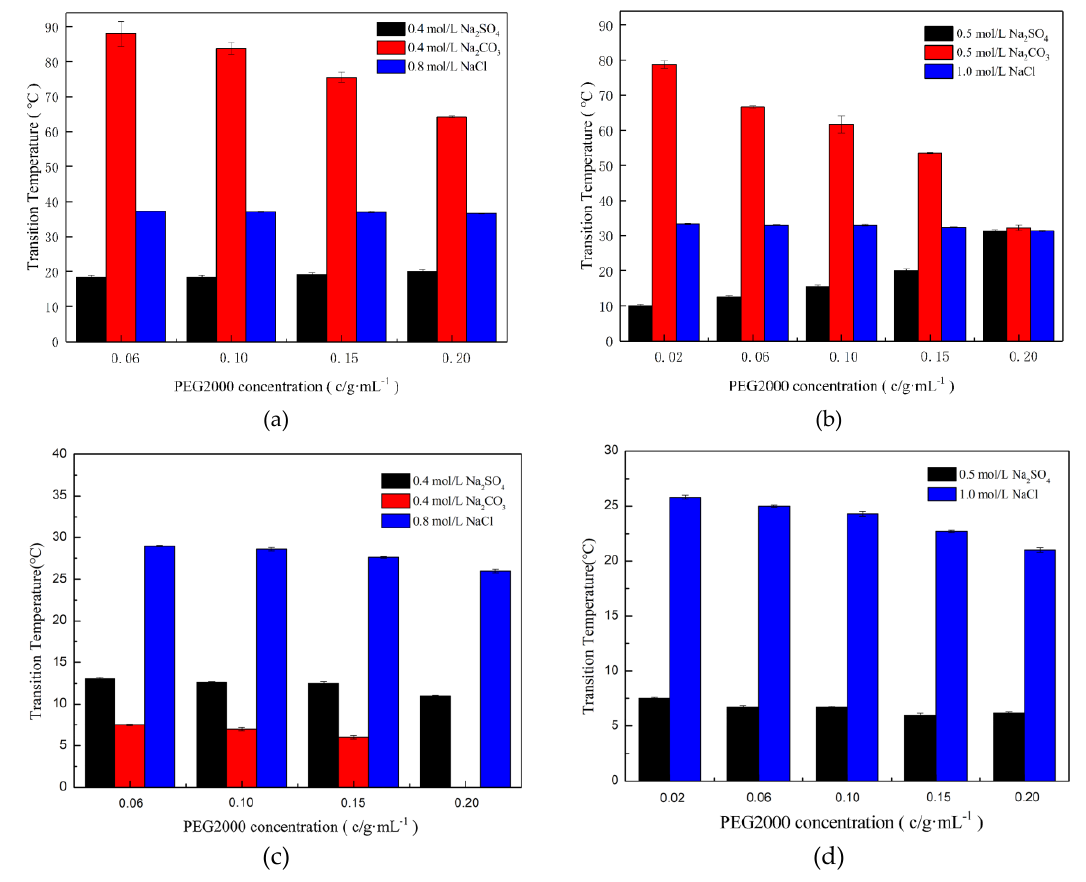
Figure 6. Effects of PEG2000 and salt concentrations on the phase transition temperature of E-C and ELPs 40 . ( a ) 0.4 mol/L salts + E-C; ( b ) 0.5 mol/L salts + E-C; ( c ) 0.4 mol/L salts + ELPs 40 ; ( d ) 0.5 mol/L salts + ELPs 40 .